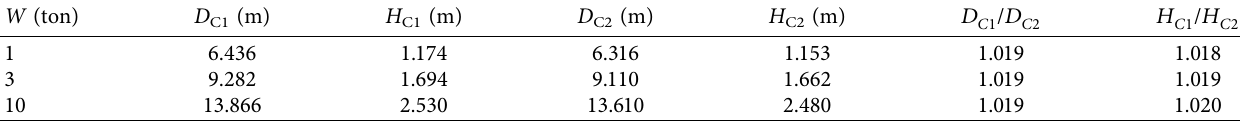
Table 11: Calculated results of the crater dimensions by different densities.